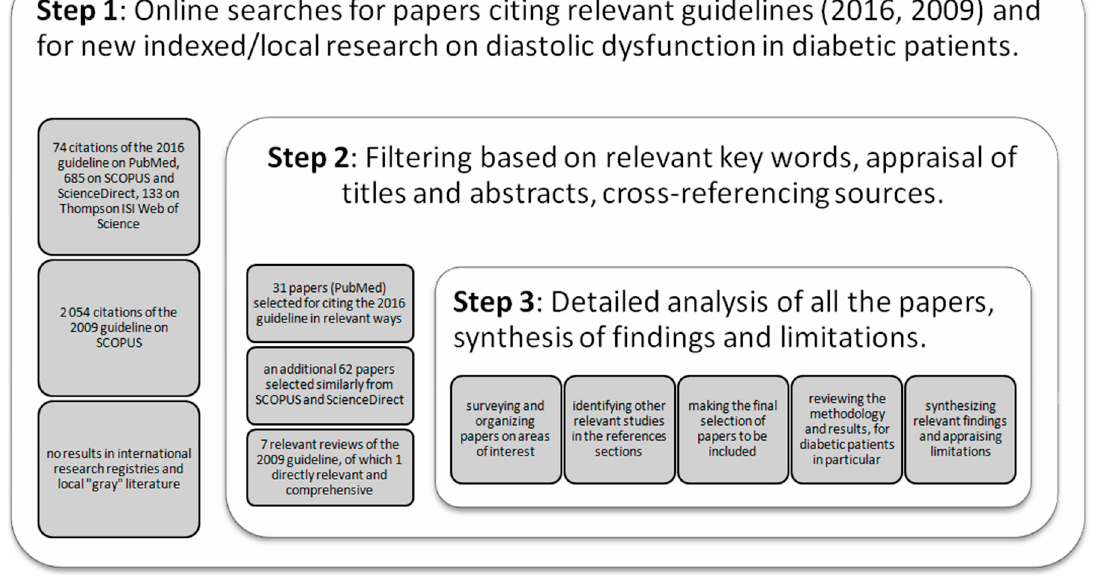
Figure 1. Flow chart for the study.